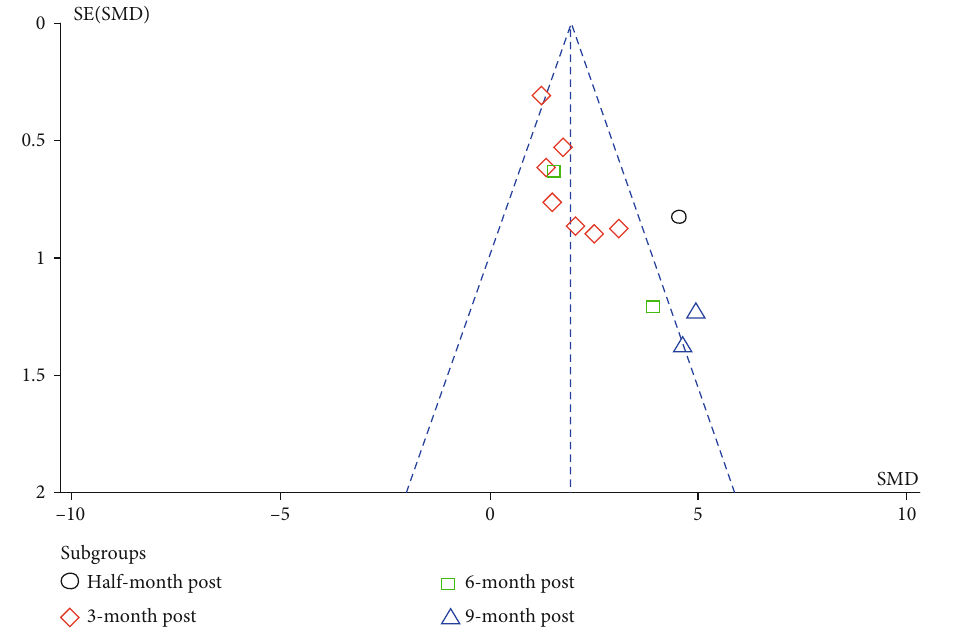
Figure 6: Funnel plot